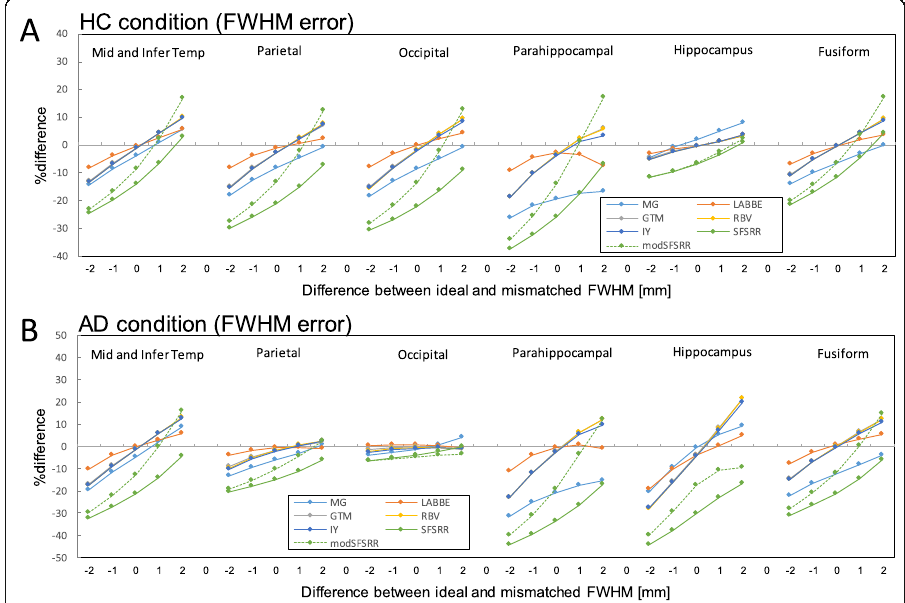
Fig. 4 %difference of PVC-SUVRs with FWHM mismatch against true SUVRs. a HC condition and b AD